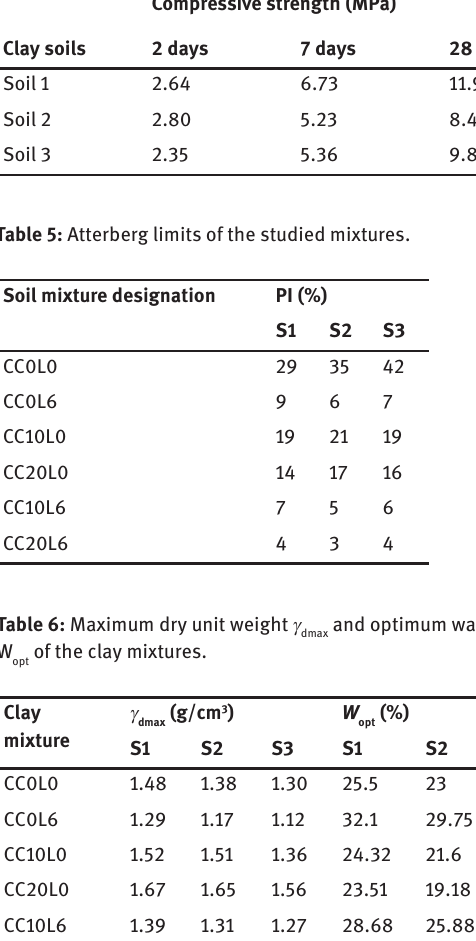
Table 4: Compressive strength of clay mortar cubes cured for 2, 7 and 28 days.